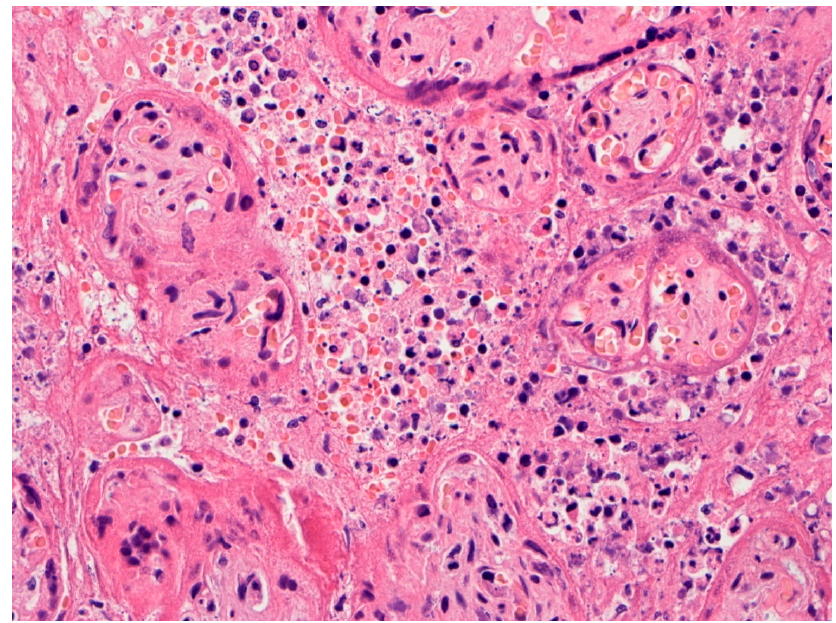
Figure 4. Higher magnification of placenta from a pregnant woman with COVID-19 in a case of transplacental SARS-CoV-2 fetal infection. Chronic histiocytic intervillositis is present in which